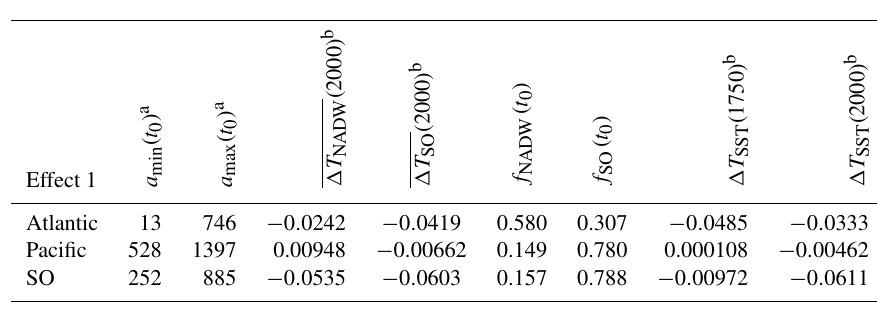
Table B1. Computing effect 1, changing SST. The first six columns containing data present a subset of the diagnosed values needed for the computation: as an example, only water masses NADW and SO and only t ∗ = 2000 are shown. The two rightmost columns show the result of effect 1 by using Eq. (B1), where all eight water masses were taken into account.